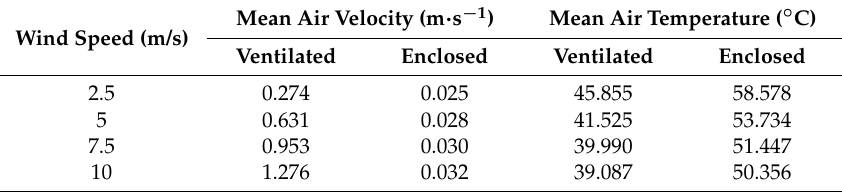
Table 4. Mean air temperatures and velocities inside the ventilated and enclosed J-tubes.